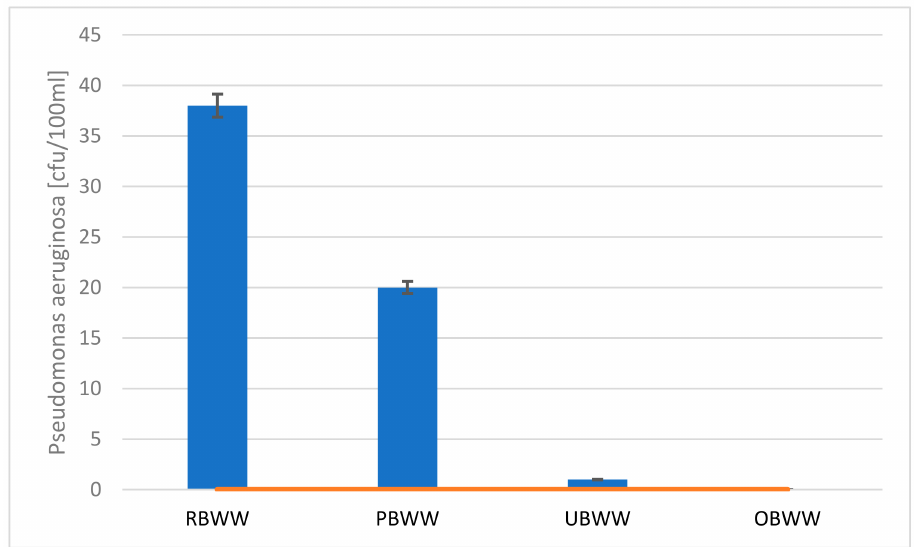
Figure 2. Change in the number of Pseudomonas aeruginosa bacteria during treatment process: raw backwash water (RBWW), pre-filter backwash water (PBWW), ultrafiltration backwash wa- ter (UBWW), ozonation backwash water